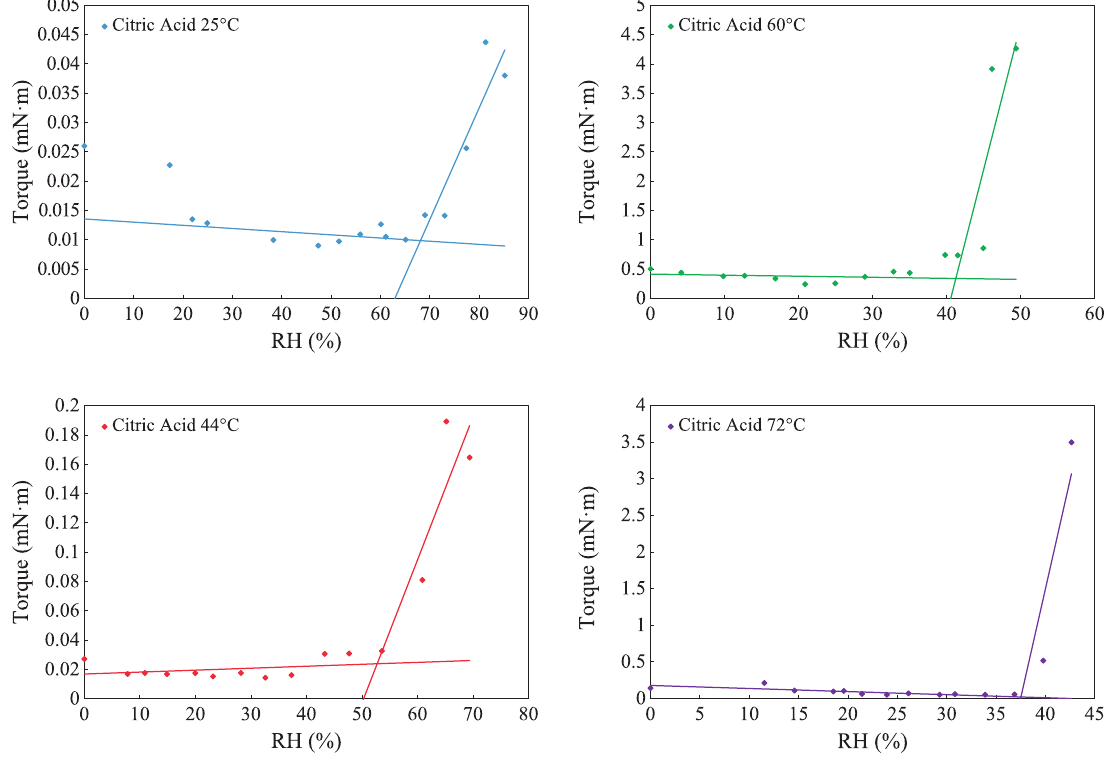
Fig. 6 Torque isotherms of the citric acid monohydrate sample at 4 different temperatures, 25 °C, 44 °C, 60 °C and 72 °C, with the fitted regions in the isotherms obtained with the Anton Paar Rheometer